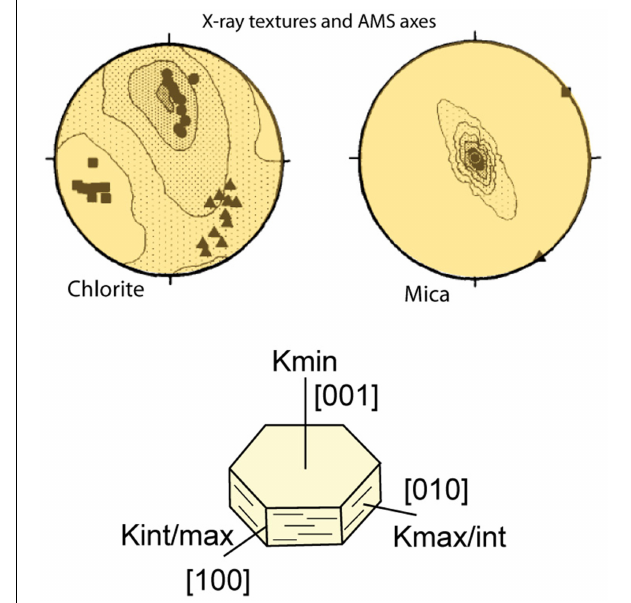
FIGURE 2 | Stereoplots for chlorite and mica dominated specimens, comparing the x-ray texture data (shaded regions) and the orientation of the principal axes of magnetic susceptibility (squares = K max , triangles = K int , dots = K min ) (modified from Richter et al., 1993). The minimum susceptibility axes show perfect agreement with the maximum density of the chlorite and mica basal